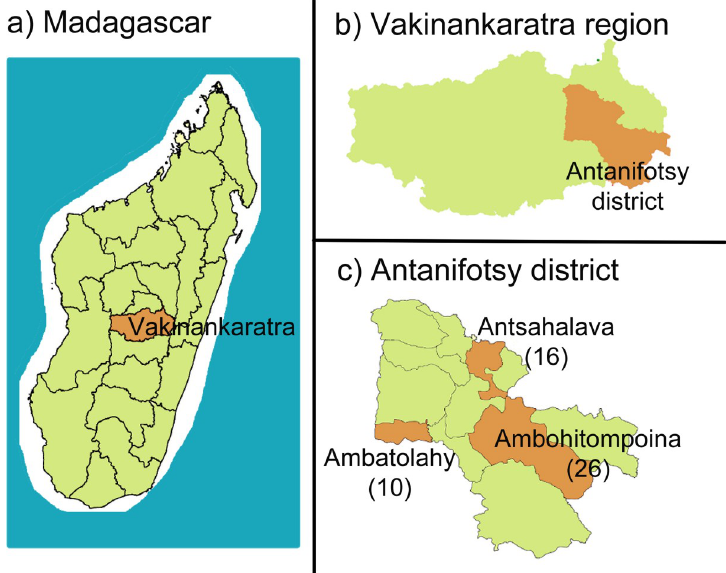
Fig 1. Map of the intervention area. a) Map of Madagascar showing Vakinankaratra region; b) Map of Vakinankaratra region showing Antanifotsy district; c) The three communes targeted (and the number of villages targeted in brackets): Ambatolahy (10), Ambohitompoina (26) and Antsahalava